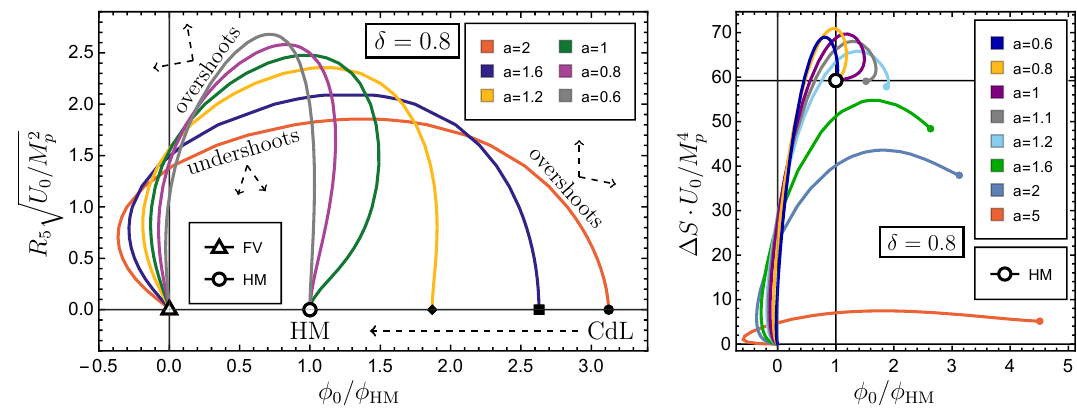
 ) Figure 27: Potential U (  and the toy 5